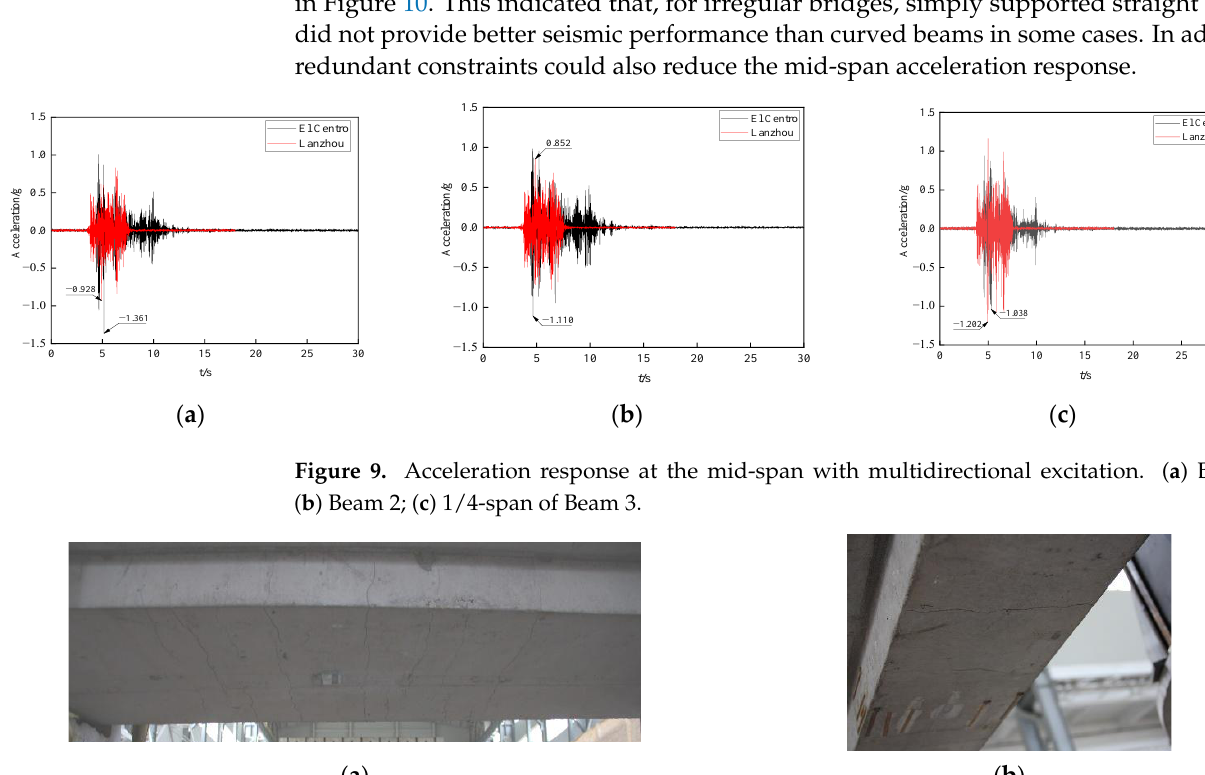
as well, but it was lighter than beam 1. Beam 3 was curved with redundant constraints and